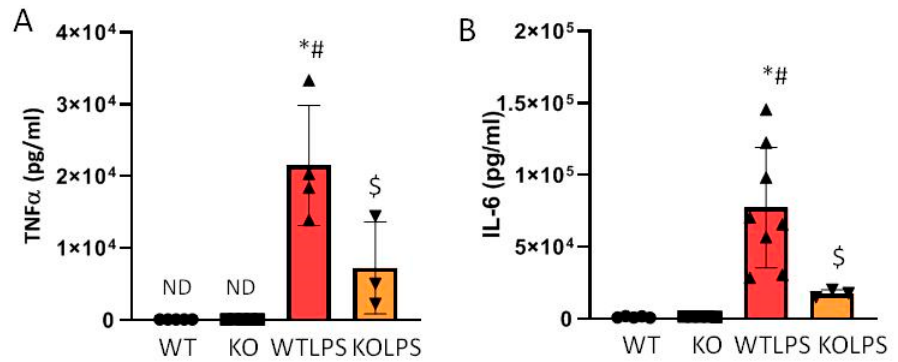
Figure 9. Determination of TNF- α and IL-6 levels in serum. TNF- α ( A ) and IL-6 ( B ) levels in serum of WT and Gal3KO animals. Blood samples were collected from the heart of mice 1 h after LPS/saline injection. Results are mean ± SD of N = 4–10 animals, expressed as ng/mLof the analyzed protein and relative to the WT group. Statistical significance (one-way ANOVA followed by the LSD post hoc test for multiple comparisons): *—compared with WT group; #—compared with KO group; $—compared with WTLPS group; p < 0.001. Abbreviations: WT, wild type mice; KO, Gal3 knockout mice; WTLPS, wild type mice treated with LPS; KOLPS, Gal3 knockout mice treated with LPS.